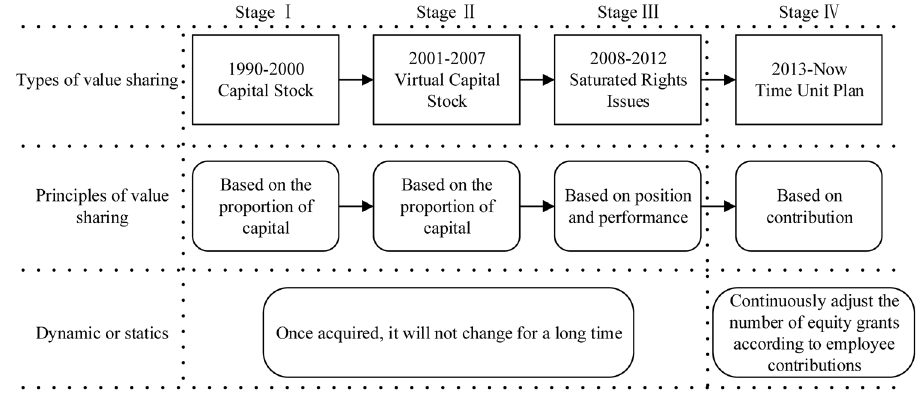
Fig. 1 Characteristics of each stage of Huawei ’ s value-sharing system. Saturated Rights Issues is similar to SVS and Time Unit Plan is similar